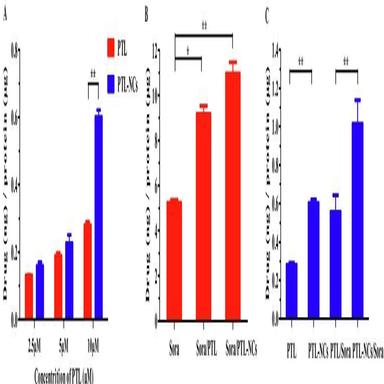
The intracellular uptake drug content of different groups was evaluated by the ratio of drug (ng)/protein (μg). (A) The PTL content in HepG2 cells in the treatment of PTL and PTL-NCs at 2.5 μM, 5 μM and 10 μM, respectively. (B) The intracellular Sora content and (C) the intracellular PTL content in HepG2 cells in the treatment of Sora (10 μM), PTL (10 μM), PTL-NCs (10 μM), Sora/PTL (10 μM/10 μM) and Sora/PTL-NCs (10 μM/10 μM). Data are presented as mean ± SD (n = 3). \ means p < 0.05, \\ means p < 0.01.